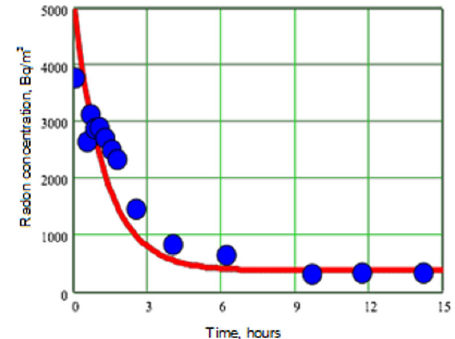
Figure 5. Change of the radon concentration in the basement with time upon activation of the ventilation of λ = 0.8 h − 1 .